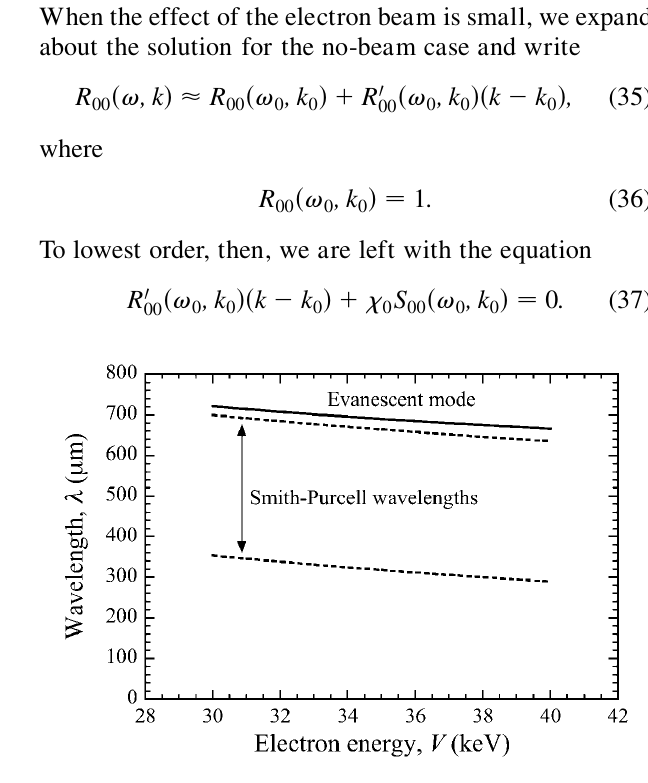
FIG. 3. Free-space wavelength of the evanescent mode (solid line), and angle-tuning wavelength range of Smith-Purcell radiation (region between the dotted lines), as functions of the electron-beam energy for the parameters of Urata and